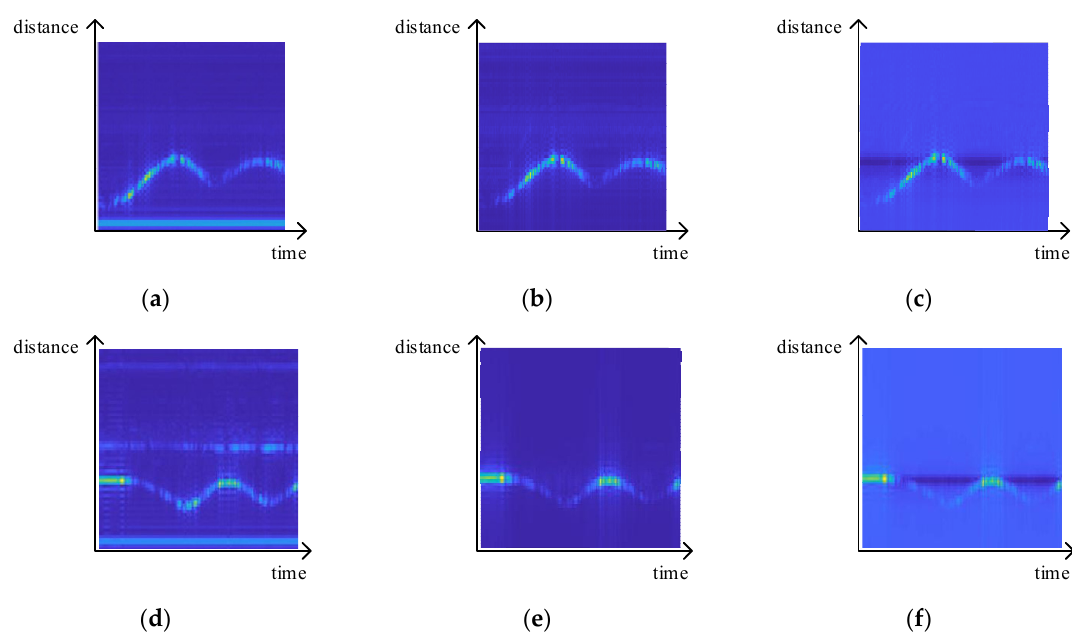
Figure 2. Different methods of clutter suppression: ( a ) original RTM with antenna coupling interference only; ( b ) RTM after high-pass filter; ( c ) RTM after average elimination; ( d ) original RTM with antenna coupling interference and body interference; ( e ) RTM after band-pass filter; ( f ) RTM after average elimination.